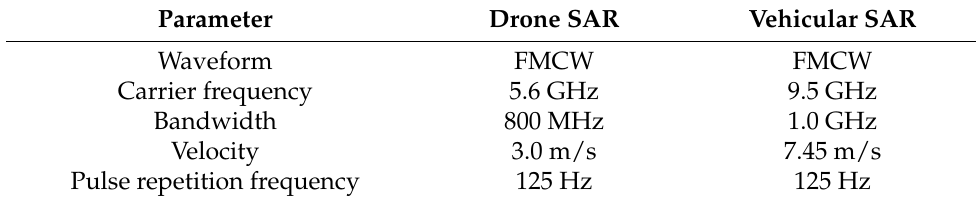
Figure 5. Self-made SAR systems and field measurement. Table 1. Parameters for drone SAR and vehicular SAR